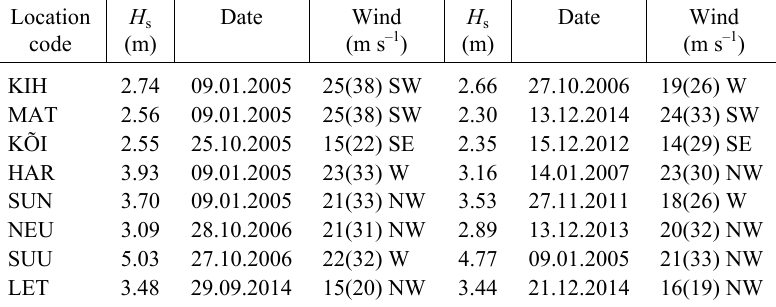
Table 4. Values and dates for two single highest ( H s ) modelled wave events for each location together with the corresponding hourly sustained (and gust) wind speed (m s –1 ) and peak wind direction. Location codes explained in Table